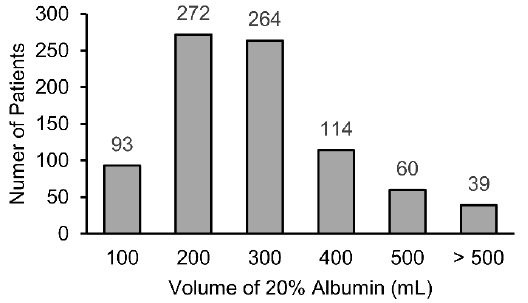
Int. J. Mol. Sci. 2023 , 24 , x FOR PEER REVIEW Figure 2. The volume of 20% albumin solution administered for each patient. Figure 2. The volume of 20% albumin solution administered for each patient.